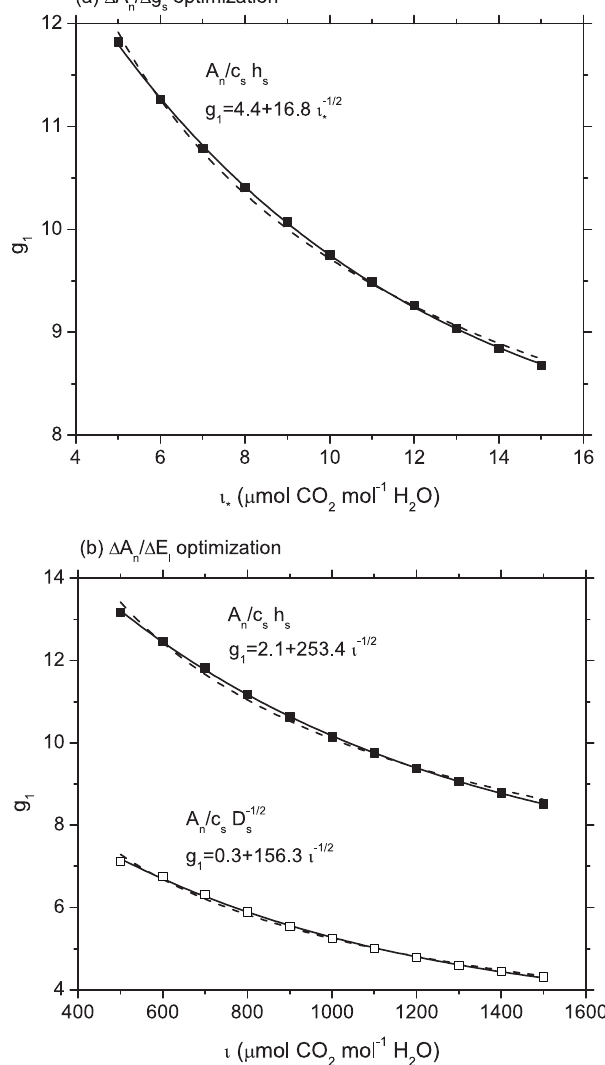
Figure 6. Slope ( g 1 ) of empirical stomatal models in relation to stomatal efficiency. (a) SPA-iWUE optimization with the slope g 1 defined for g s ∝ A n /c s h s . (b) SPA-WUE optimization with the slope g 1 defined for g s ∝ A n /c s h s (closed symbols) and g s ∝ − 1 / 2 A n /c s D s (open symbols). Solid lines show an exponential regression equation ( R 2 = 0.99). Dashed lines show the fit to − 1 / 2 − 1 / 2 (b) ι ∗ (a) and ι